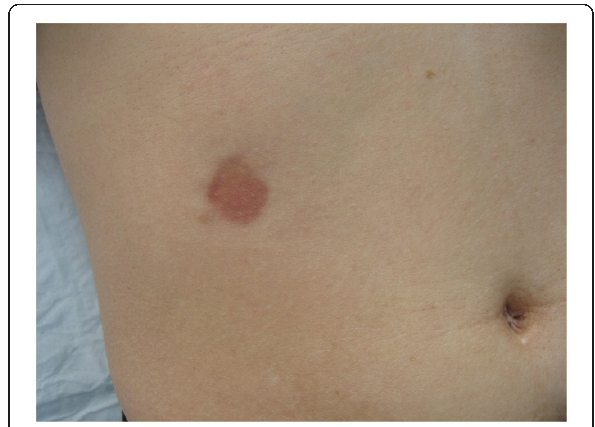
Figure 1 A smooth-surfaced, round, depressed plaque on the right pars lumbalis area.